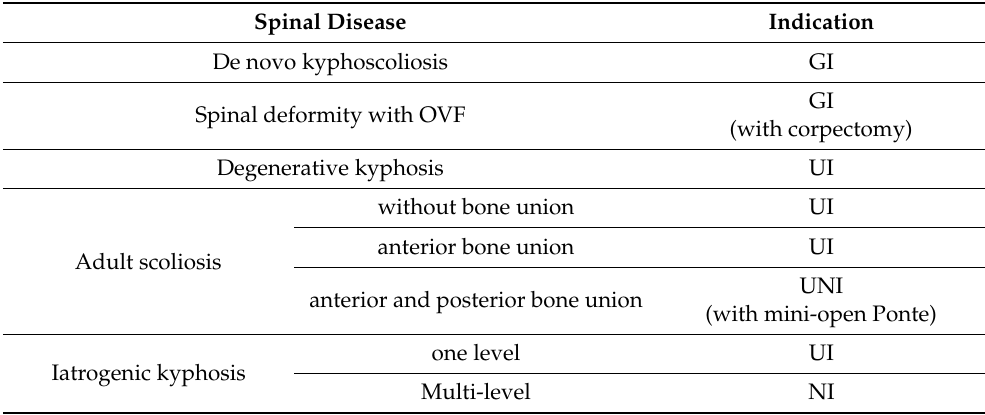
Table 1. Indications for CMIS in ASD.